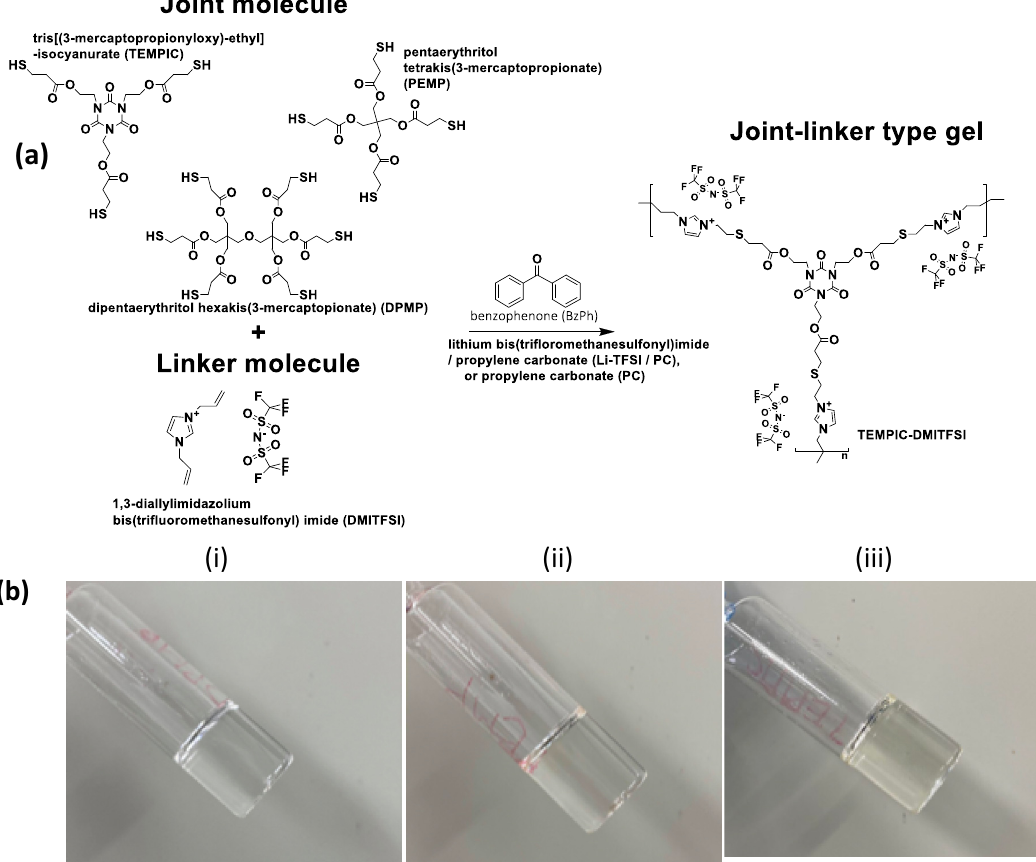
Figure 1. ( a ) Schematic synthesis via thiol-ene reaction between multifunctional thiol monomers and DAIM TFSI linker. ( b ) Images of the gels ( i ) DPMP-DAIM TFSI ( ii ) PEMP-DAIM TFSI and ( iii ) TEMPIC-DAIM TFSI in Li-TFSI/PC (1 M) solvent, monomer concentration: 30 wt %.